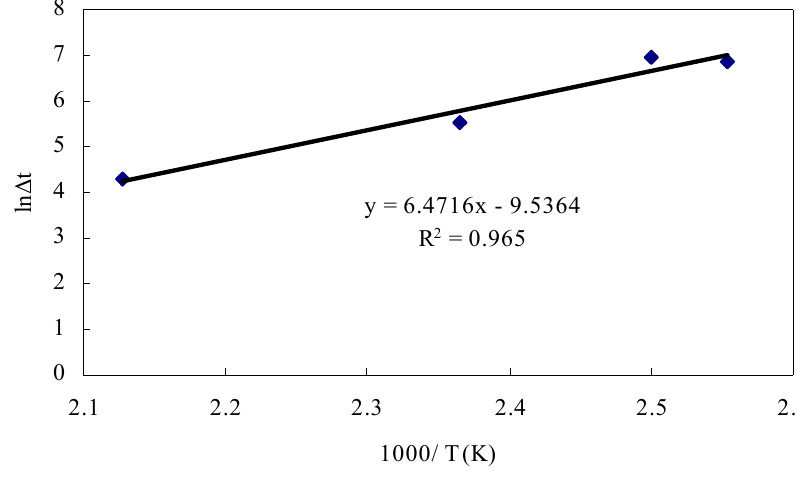
Figure 10. Correlation of induction time to ignition and temperature for